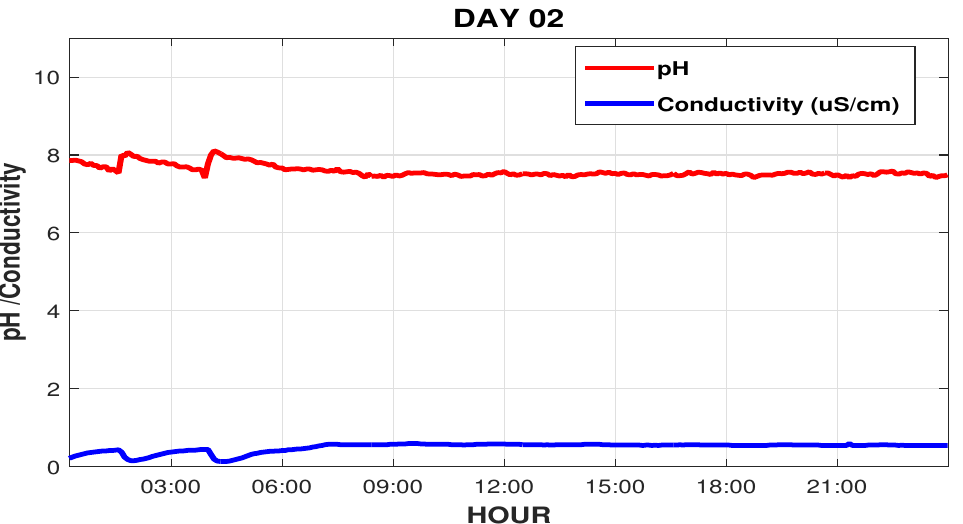
Figure 19. pH and RO conductivity readings on the second intervention